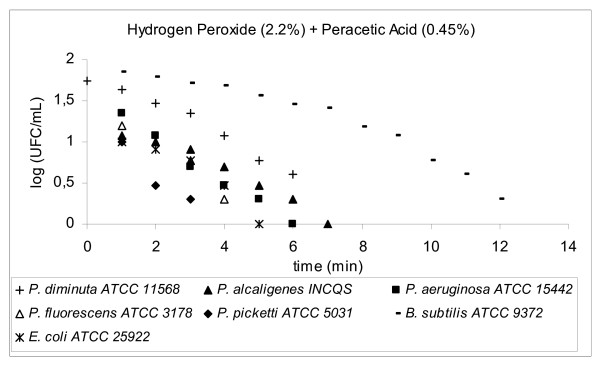
Graphic representation of the standard and in house microorganism reduction against different sanitizers.